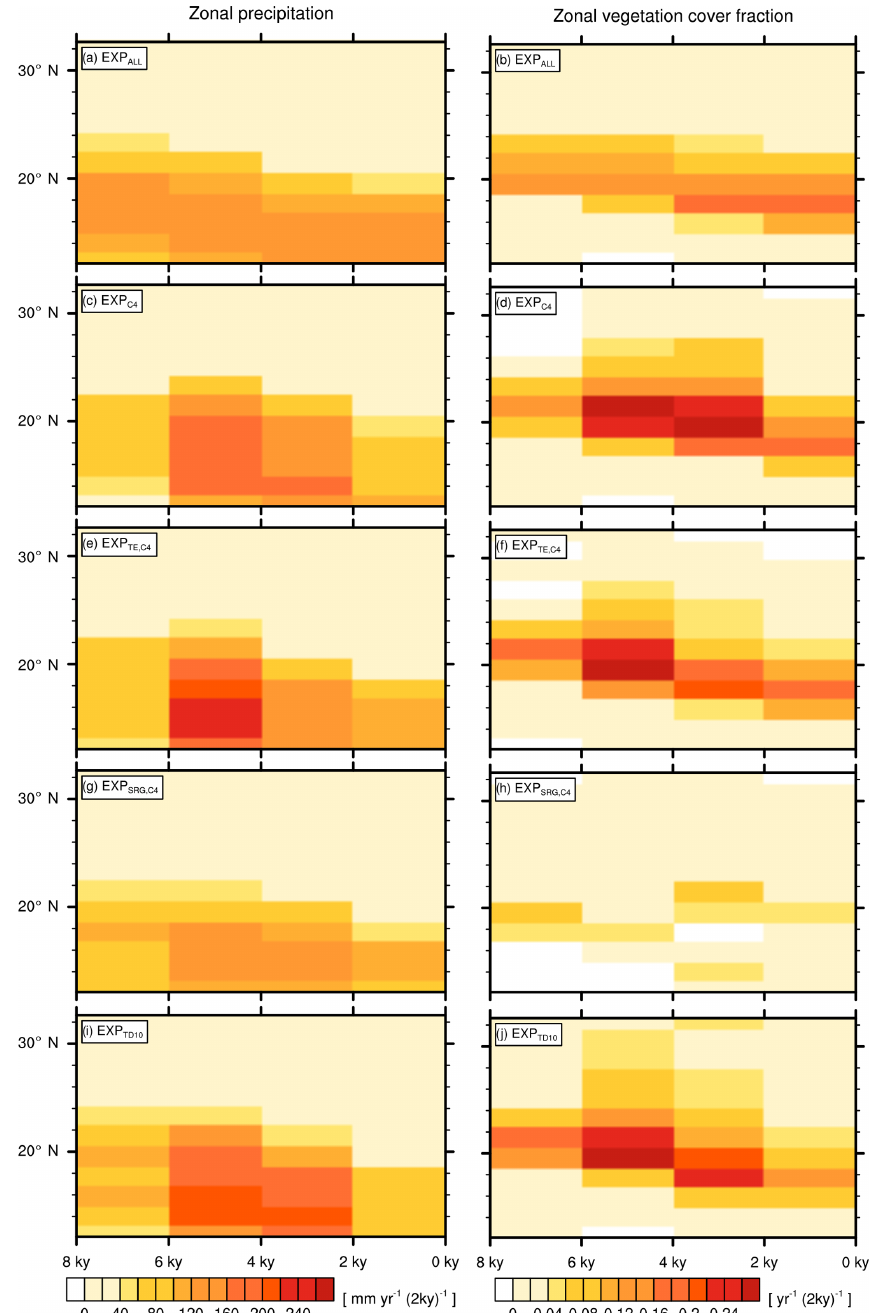
Figure 6. Zonally averaged transition rates from the green Sahara to the desert state for precipitation (cid:49)P i (left column) and vegetation cover fraction (cid:49) veg max ,i (right column). Plots depict differences between consecutive time slices (100-year averages) for EXP ALL (a, b) , (c, d) , EXP TE , C (e, f) , EXP SRG , C (g, h) , and EXP TD (i, j) EXP C 10 4 4 4